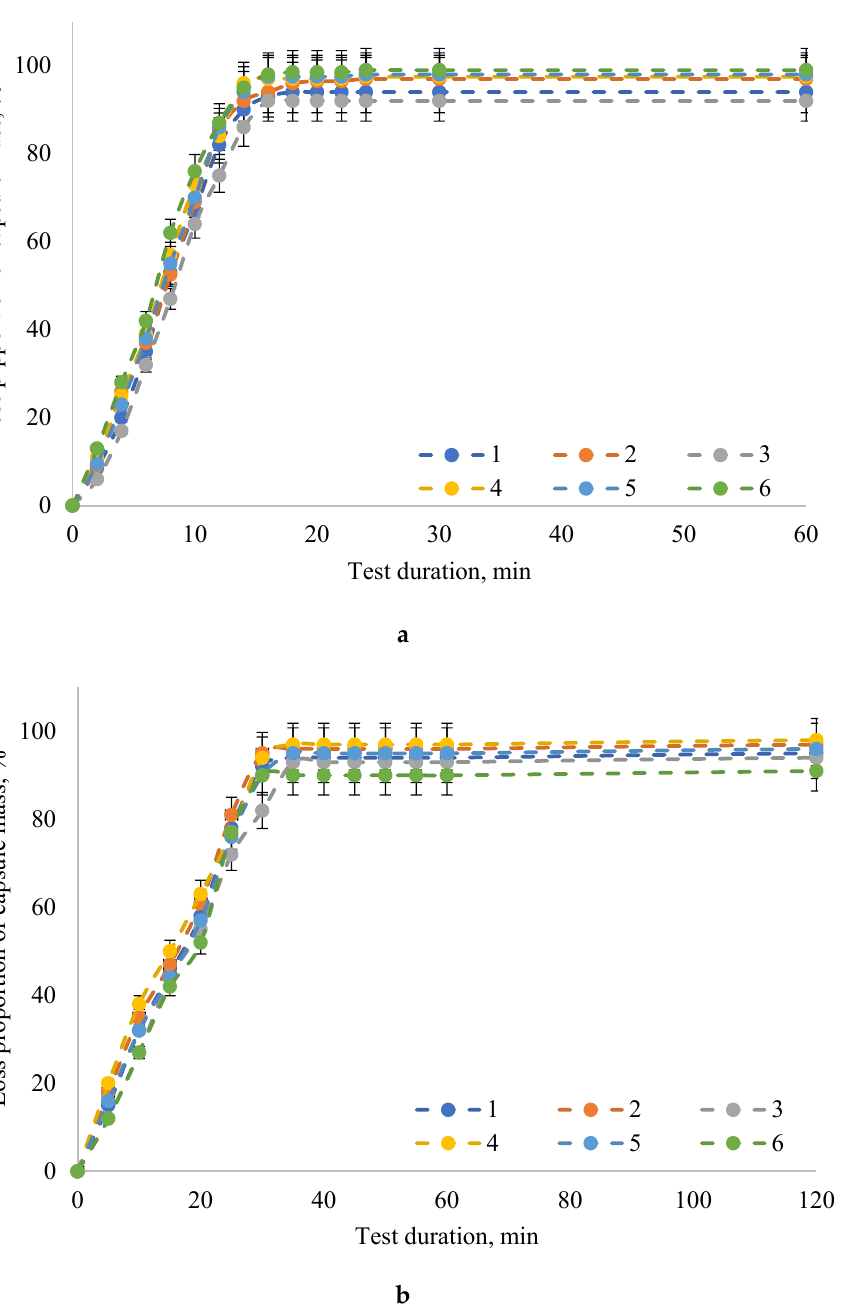
Figure 2. Dynamics of the in vitro degradation of the encapsulated form of the PAL enzyme preparation in intestinal model media ( a ) SIF and ( b ) FaSSIF: 1—samples of capsules made according to